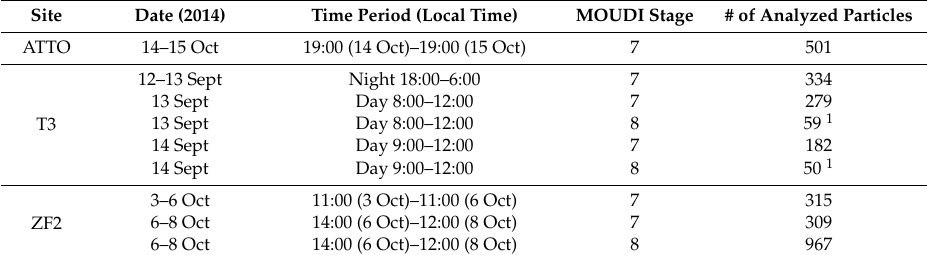
Table 1. Samples examined for this study. The nominal size range for Micro-Orifice Uniform